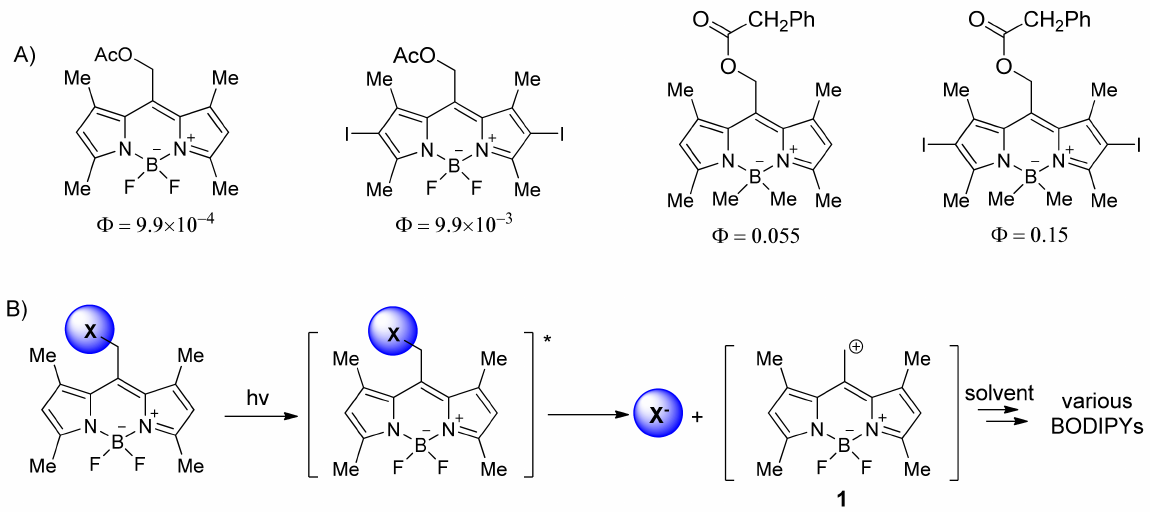
Figure 1. ( A ) BODIPY-based PPG with QY of photorelease. ( B ) Proposed mechanism of photorelease. * Excited state of the